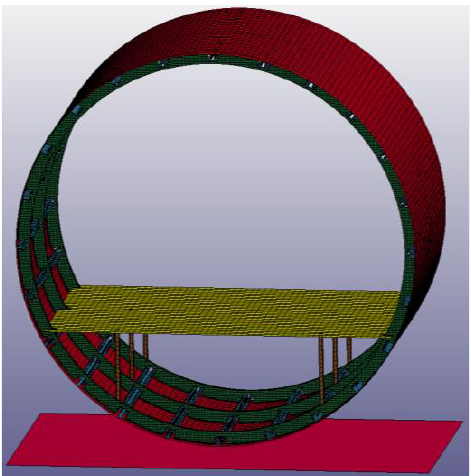
Figure 2: FE model of the fuselage and